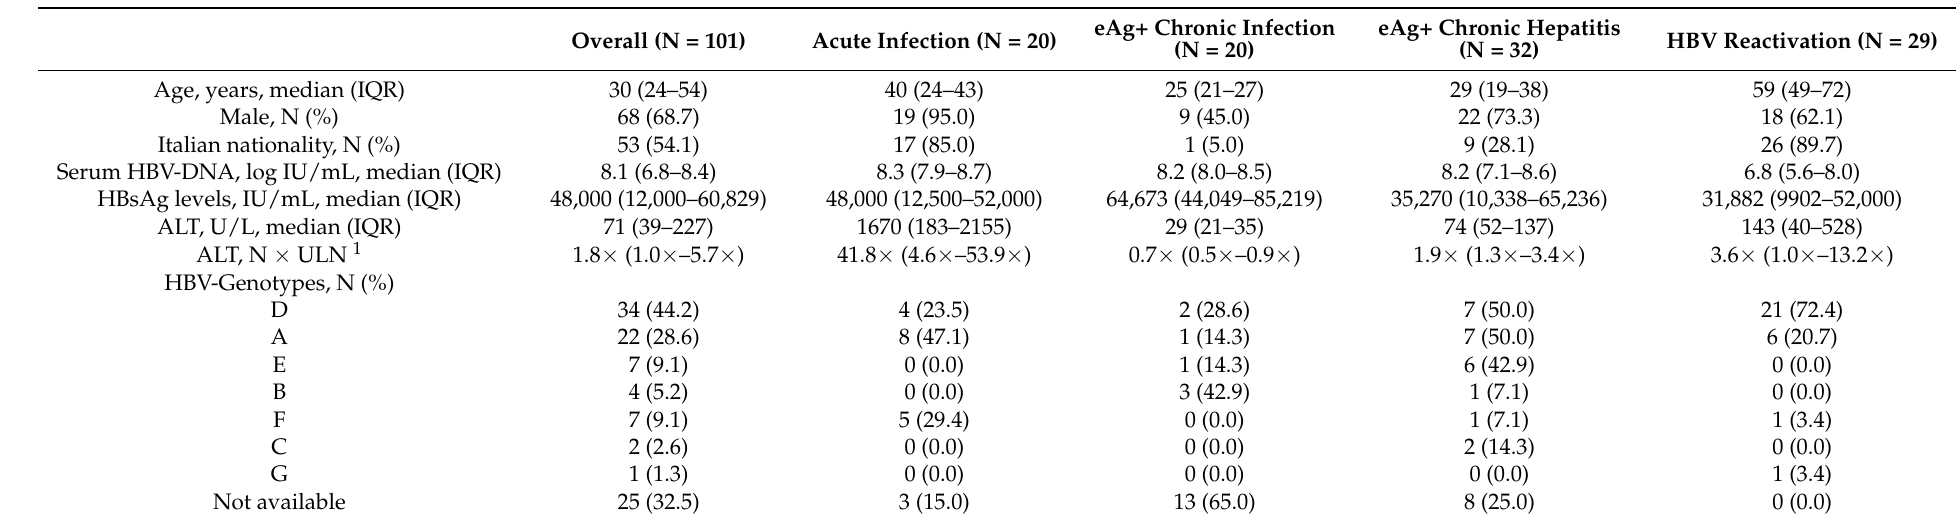
Table 1. Patients’